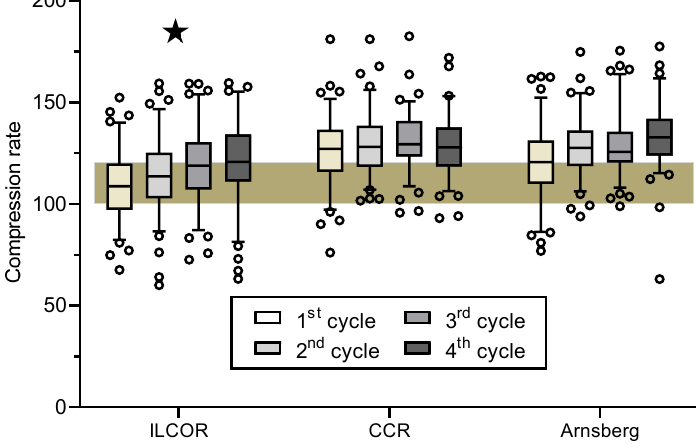
Figure 5. Chest compression rates. Box and whiskers plot of chest compressions rates (strokes per minute) during the first four CPR cycles in the three study groups. Boxes indicate the median and the lower and upper quartiles while the whiskers indicate the 5th and 95th percentiles. The brownish shaded area represents the range of 100–120 compressions/min recommended by the current guidelines [1,2]. = p < 0.001 vs. both other groups.